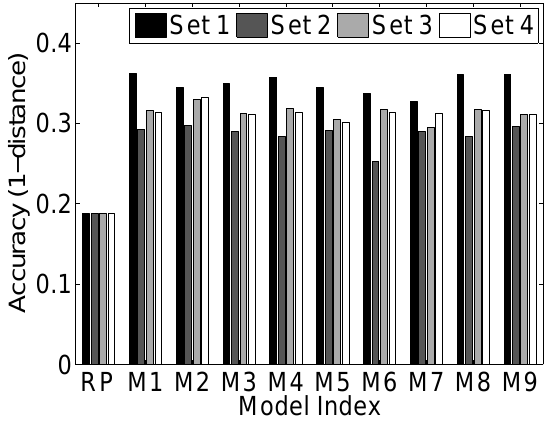
Figure 6. Markov chain